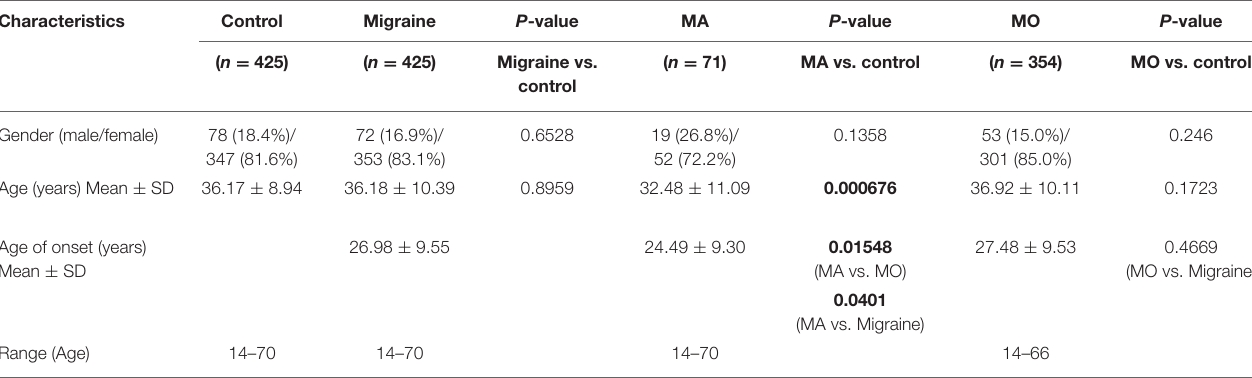
TABLE 1 | Demographic characteristics of the study subjects.